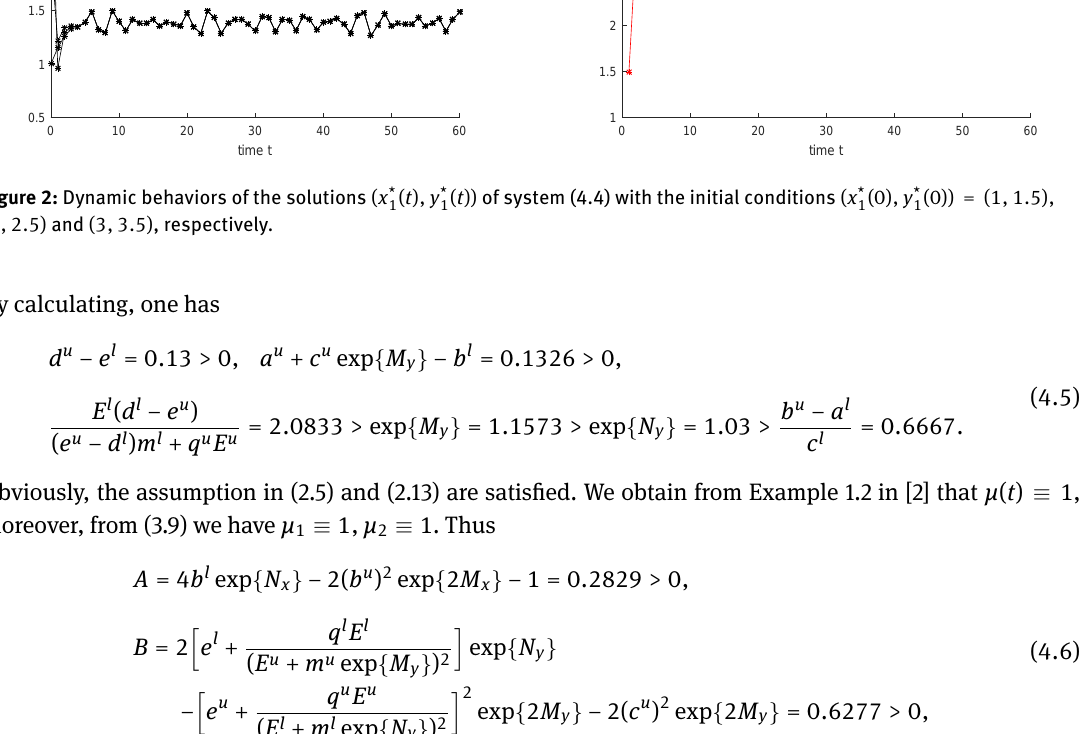
(0), y * (0)) = (1, 1.5), 1 1